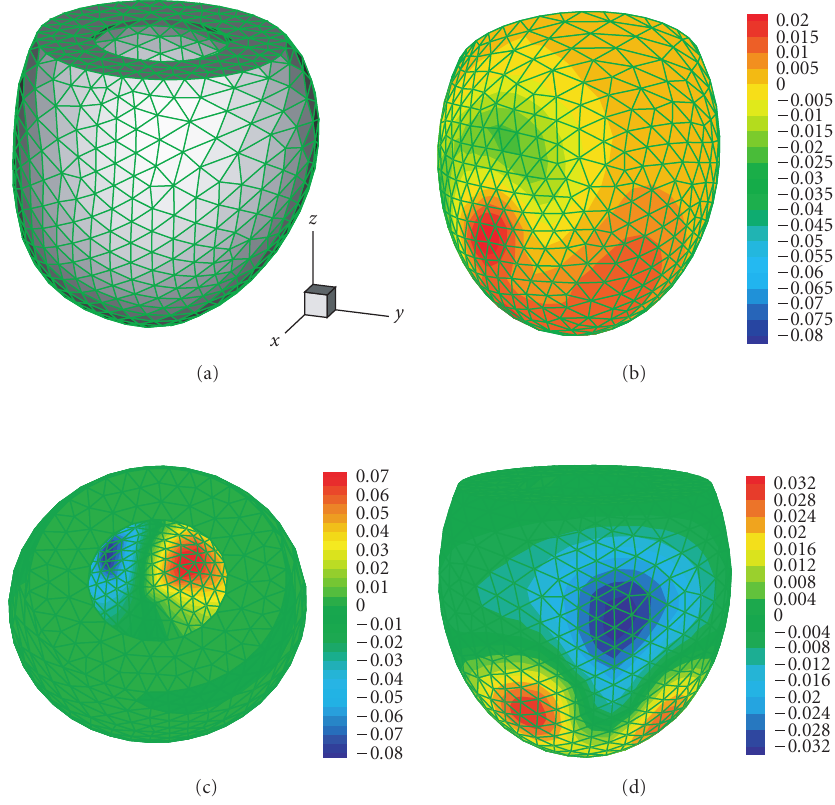
Figure 5: (a) Deformation of ischemic LV phantom at t = 0 . 4 second (passive phase); (b), (c), and (d) di ff erences of epicardial/endocardial displacement components u x , u y , and u z , respectively, between ischemic and normal LV phantoms. View angles and contour levels are chosen for best